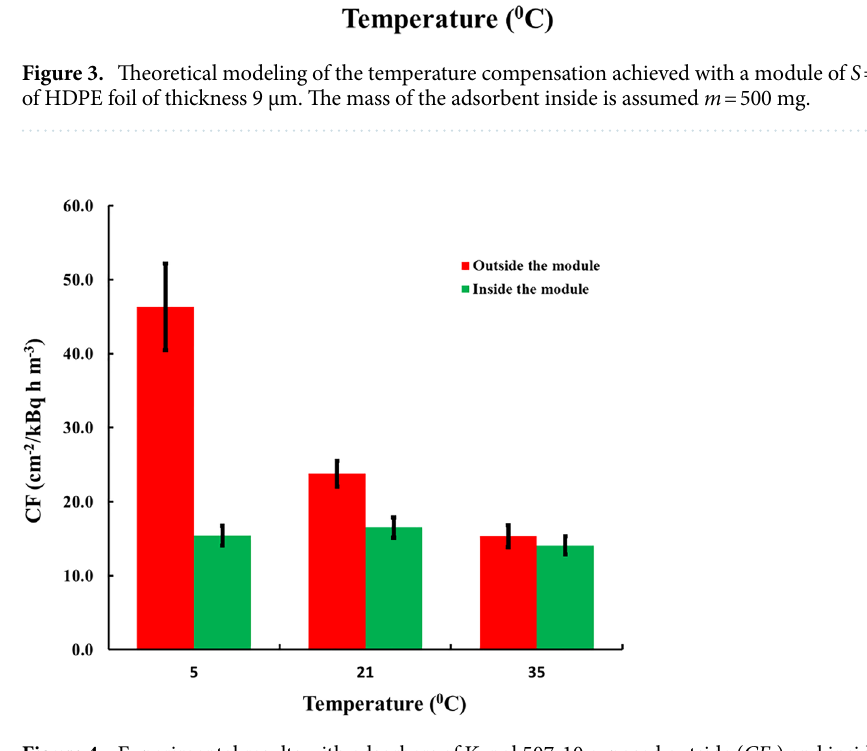
Figure 4. Experimental results with adsorbers of Kynol 507-10 exposed outside ( CF 0 ) and inside ( CF ) modules of 9 µm thick foil of